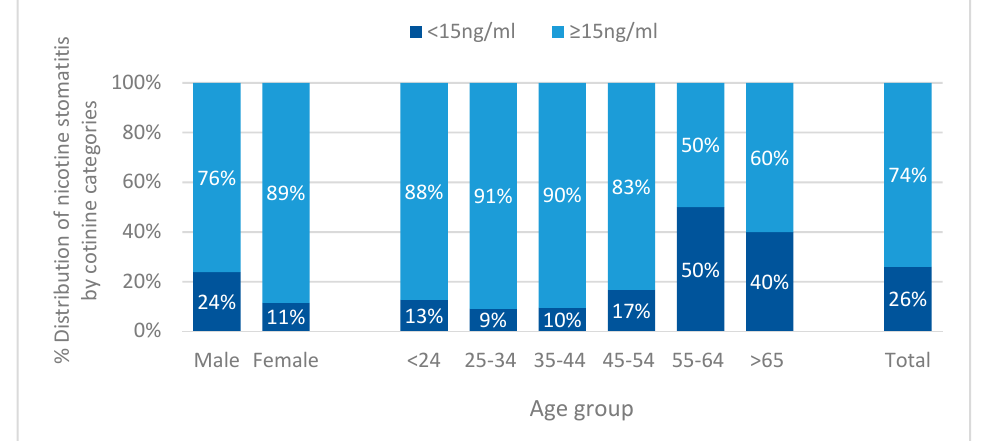
Figure 3. Distribution of nicotine stomatitis according to serum cotinine categories ( < 15 ng / mL and ≥ 15 ng / mL) in relation to sex ( p = 0.03 for males, p < 0.001 for females), age group ( p = 0.009 for 25–34, p = 0.002 for 35–44 and p = 0.001 for 45–54), and total ( p < 0.001).